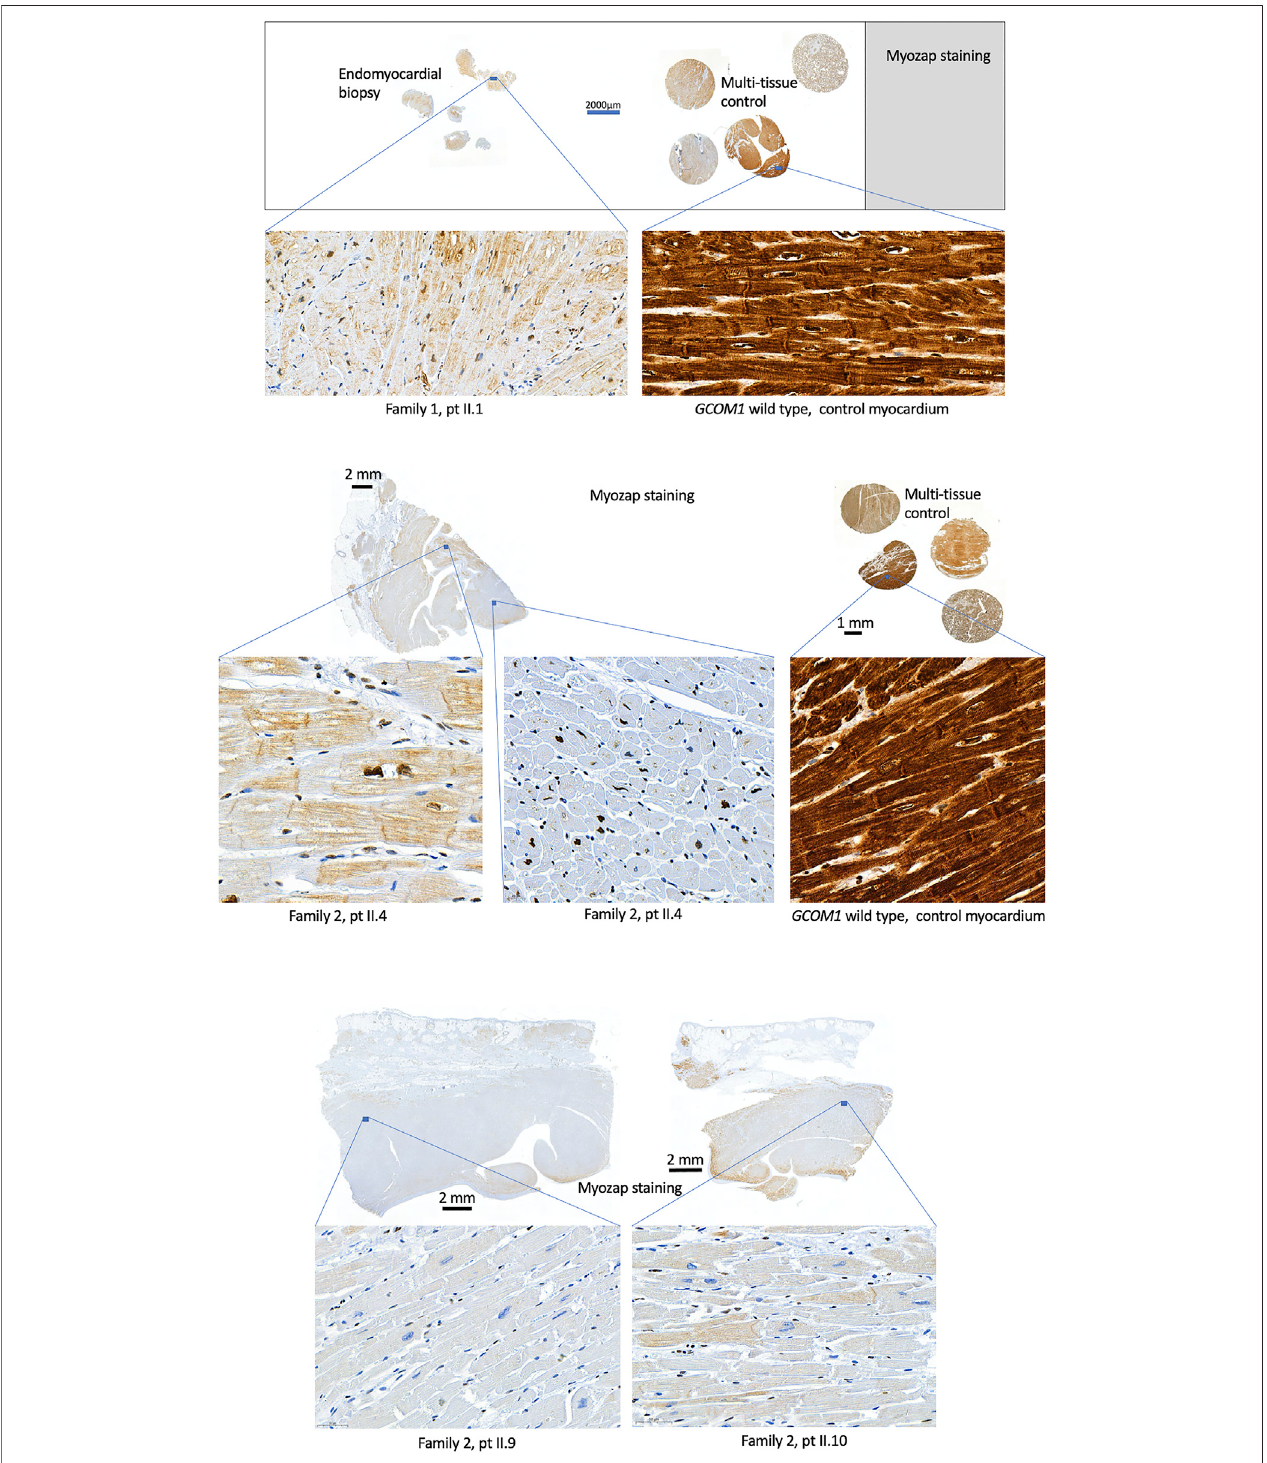
FIGURE 4 | Histological samples. Myozap-staining of myocardial samples from homozygotes (Family 1: II.1 and Family 2: II.4, II.9, II.10) show clear loss of staining when compared to the wild type GCOM1 control samples. Controls with primary antibody omitted or substituted with rabbit non-immune IgG showed no staining (Data not